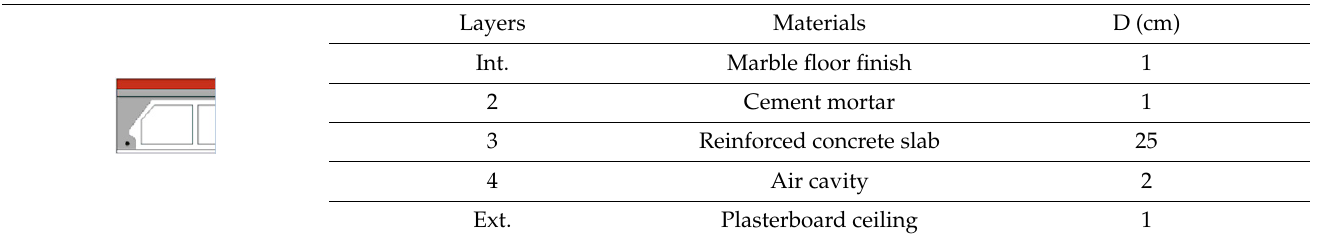
Table A1. Main thermal and geometrical properties of the present building envelope and